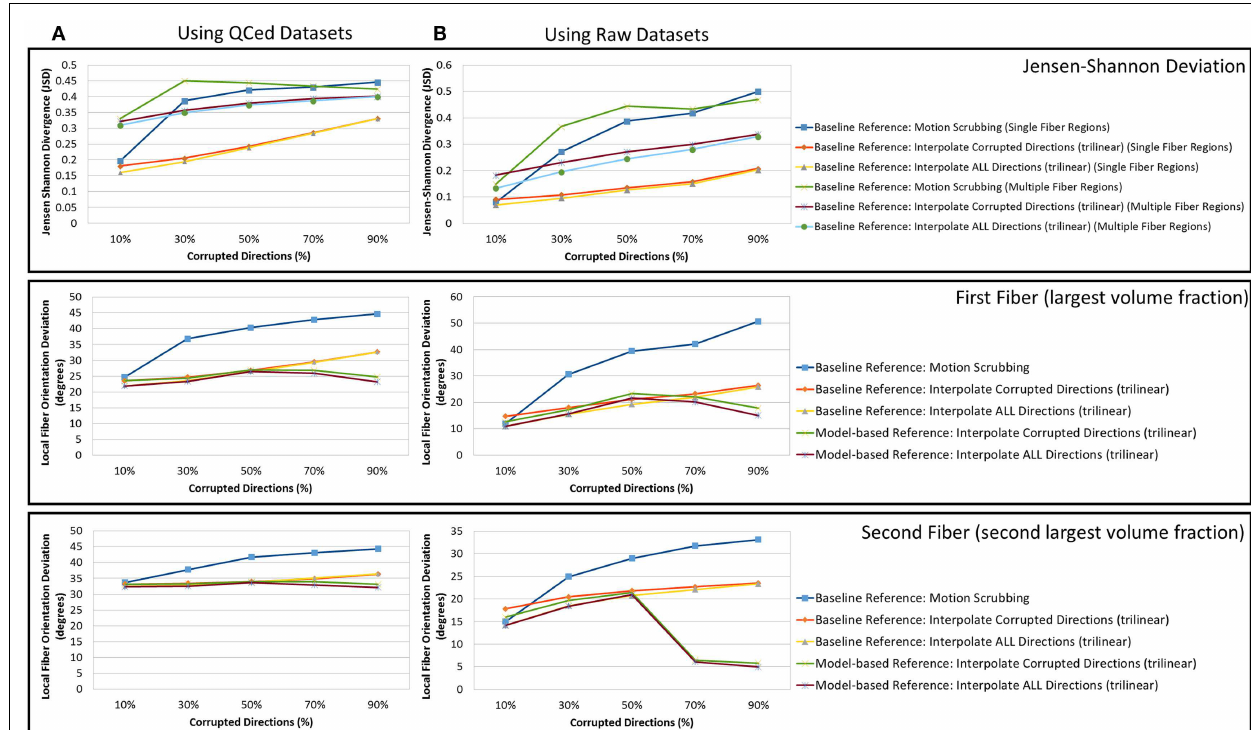
the raw phantom dataset . Note the agreement between (A) and (B) where the impact of motion scrubbing becomes more significant with more motion-corrupted directions when compared to registration-based correction. This effect is also rendered evident for local fiber